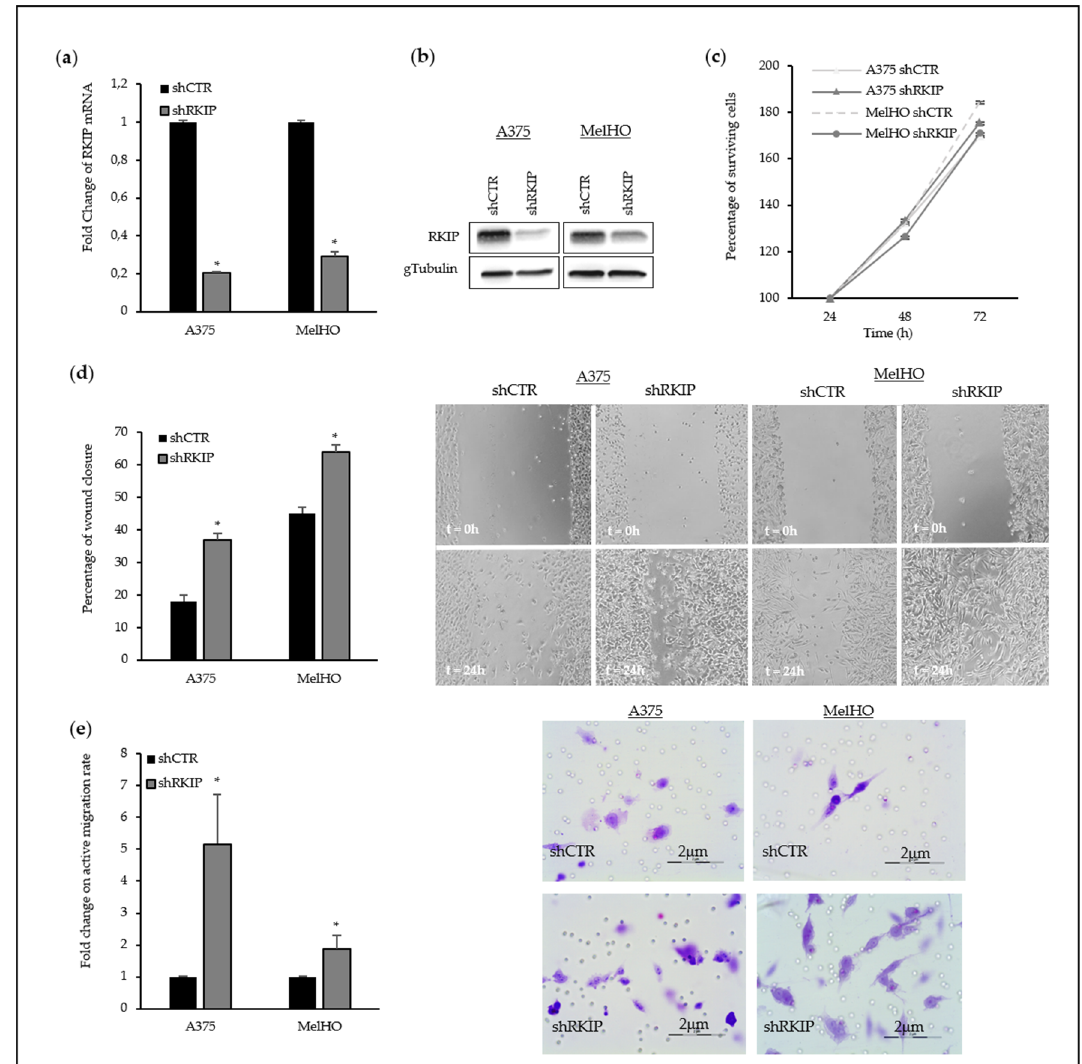
Figure 3. Modulation of RKIP expression in primary melanoma cell lines. ( a ) RKIP mRNA levels in RKIP-downregulated A375 and MelHO primary melanoma cell lines. A375 and MelHO cells were transduced with RKIP shRNA Lentiviral Particles or Control shRNA Lentiviral Particles following the manufacturer´s instruction. Two days after infection, the cells were selected with Puromycin to get stable cell lines; ( b ) Western Blot assay showed the RKIP-downregulation in A375 and MelHO melanoma cells; ( c ) Proliferation rate in A375 and MelHO primary melanomas after RKIP downregulation. The viability of control melanoma cells (with an empty vector) and stable RKIP transfected clones were subjected to XTT assays for 24, 48, and 72 h. Results of each experiment are expressed related to the values obtained for the transfection control. Data is given as a mean ± SD of at least three experiments of di ff erent transfection; ( d ) Fold change on wound healing rate in A375 and MelHO primary melanoma after RKIP downregulation; ( e ) Fold change on active migration rate in presence of collagen in primary melanoma after RKIP downregulation. The histograms in ( d ) and ( e ) show the average of three independent assays with six replicates per assay and representative pictures have been included. * p -value < 0.05.